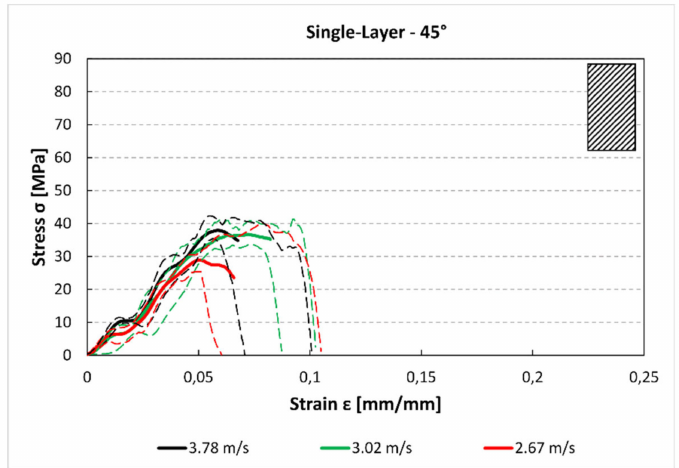
Figure 5. Single-layer stress–strain curve for 0 ◦ specimen and for each impact speed.